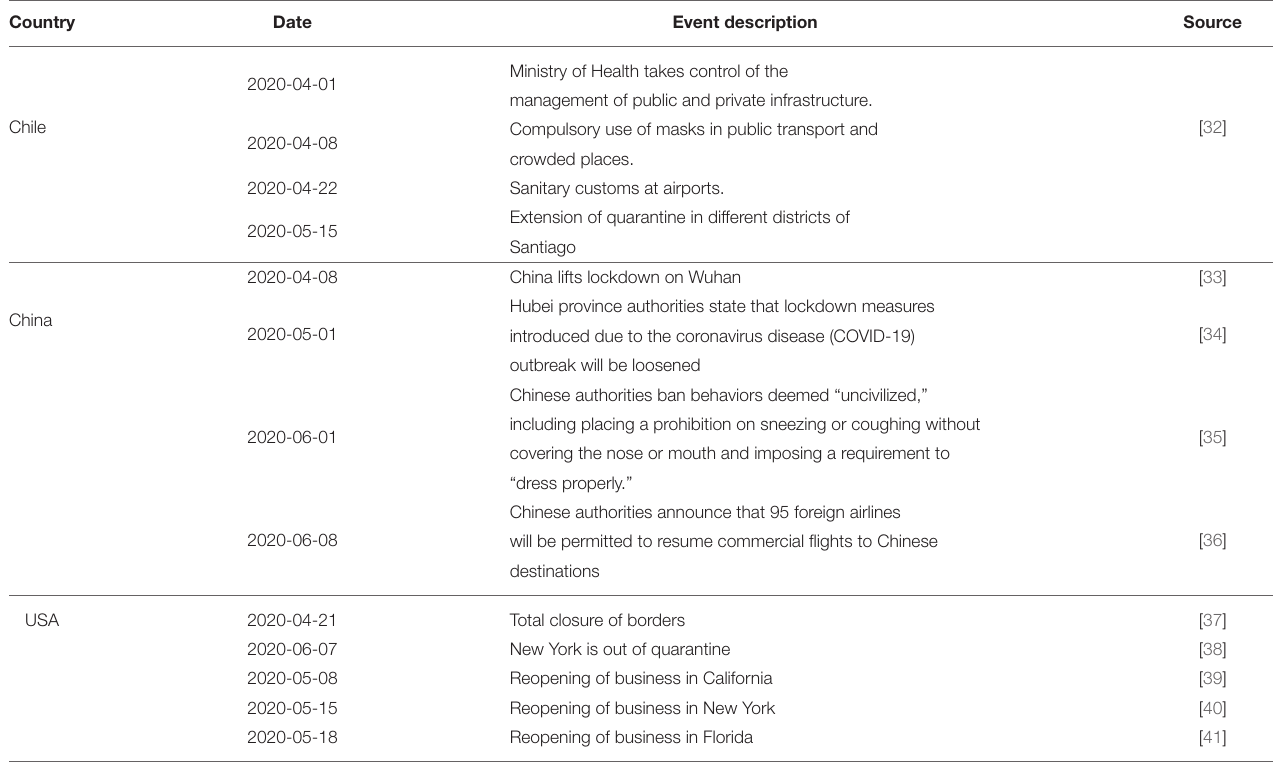
TABLE 2 | Summary of the main governmental actions carried out by iconic countries to control the SARS-CoV-2 outbreak.